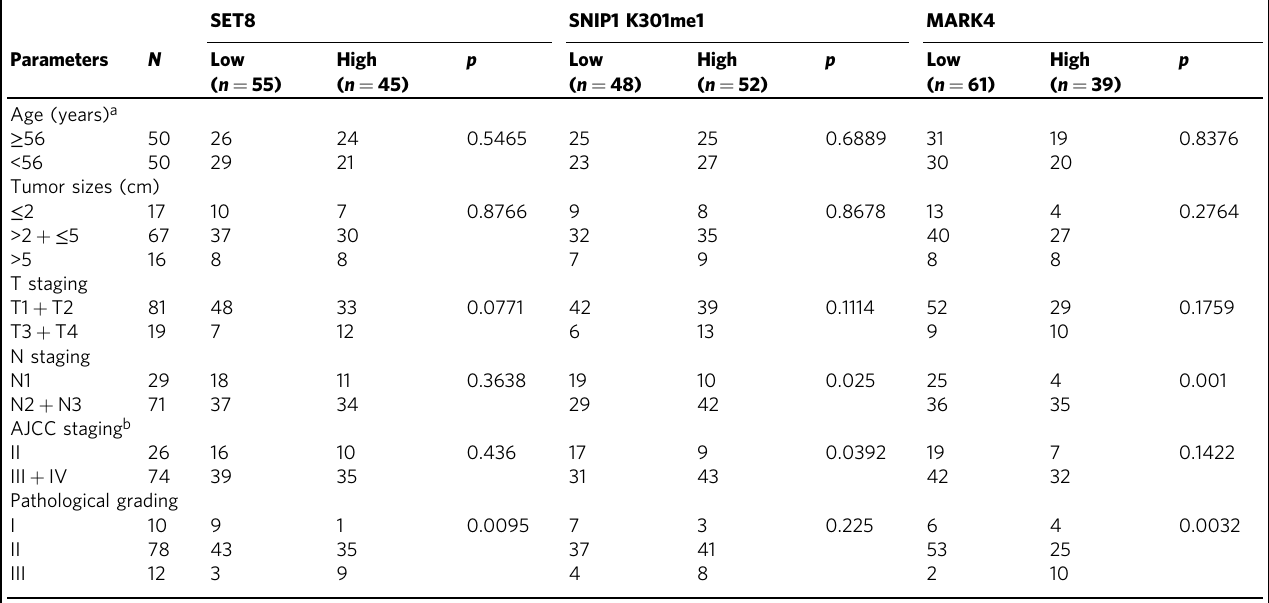
Table 1 Correlation between different expression levels of SET8, SNIP1 K301me1, and MARK4 with clinicopathological parameters of individuals with